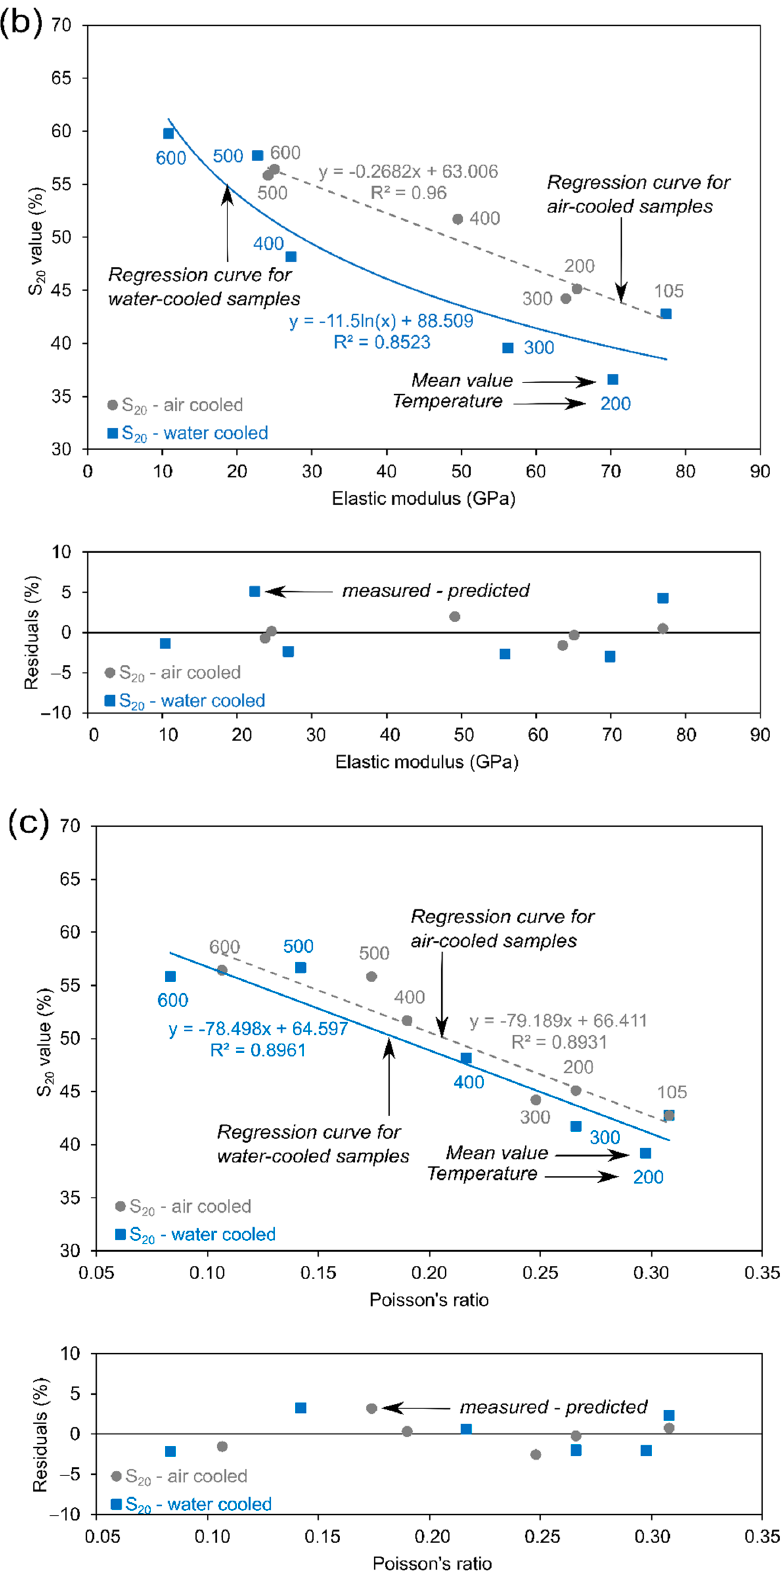
Figure 11. Correlations between variation of S 20 and: ( a ) UCS; ( b ) elastic modulus; and ( c ) Poisson’s ratio for air- and water-cooled samples.